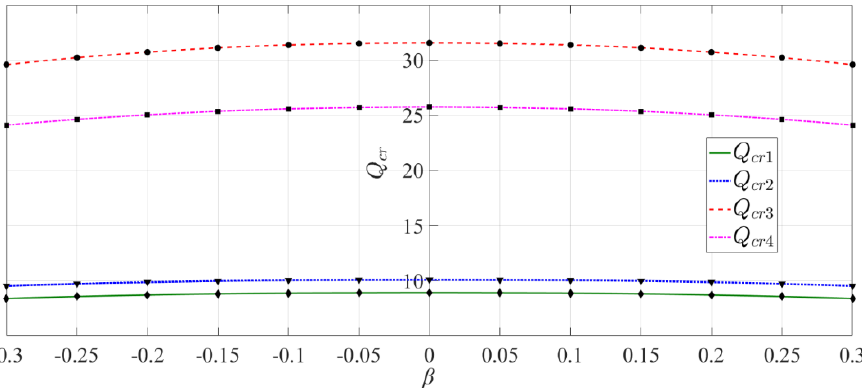
Figure 10. Variation of four critical loads Q cr with β ( λ h = 1.0 and λ t = 0.03).